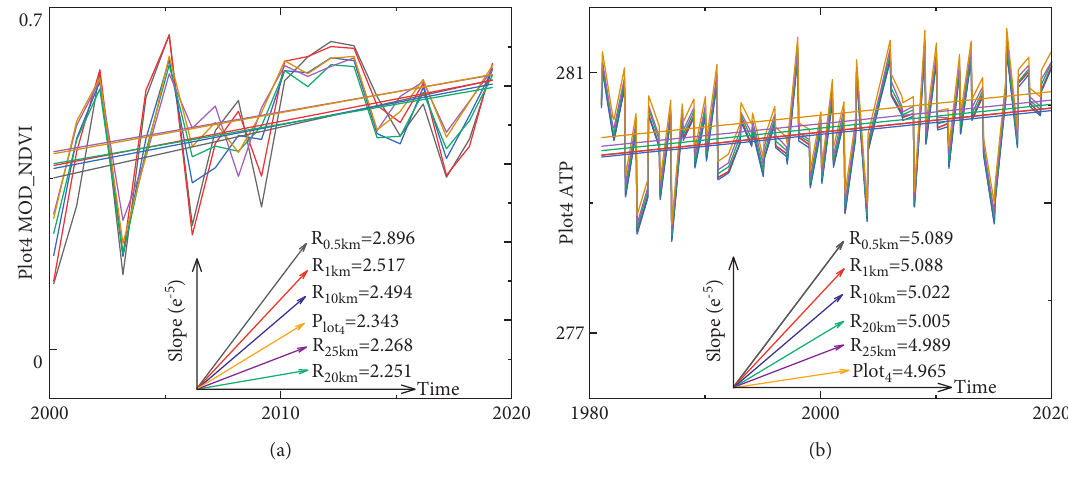
Figure 16: Slope varies with statistical